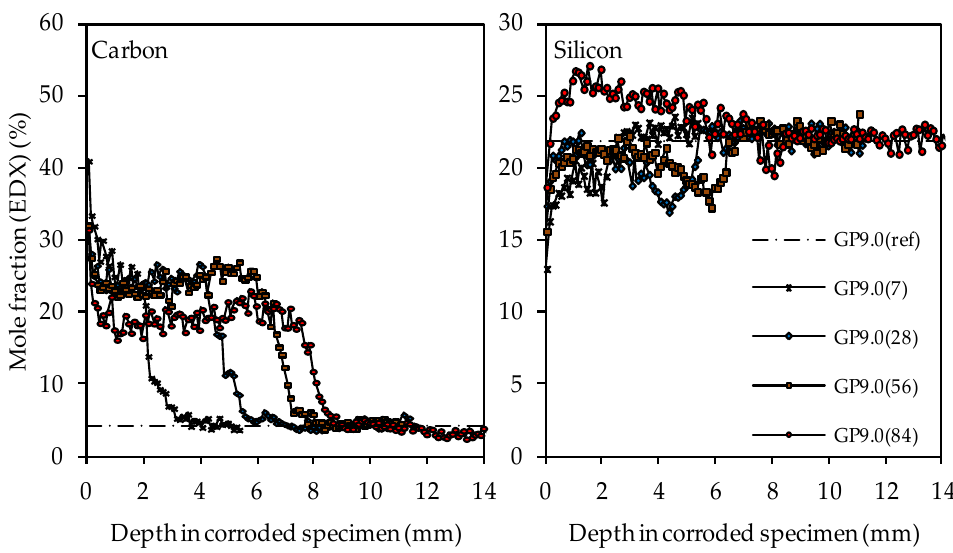
Figure 16. SEM-EDX mole fractions of carbon and silicon of geopolymer GP9.0. Mole fractions before (ref) and after (7, 28, 56, 84) exposure to sulfuric acid.